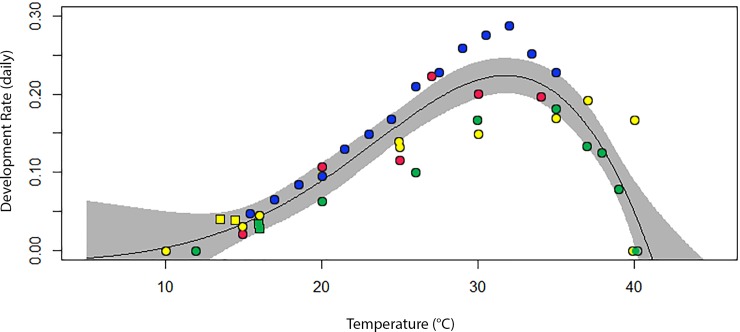
Non-linear development model for larval Aedes aegypti.Comparison of the mean and median time to pupation from published larval development rates, including the current study [14, 26, 30, 31, 32]. To these estimates we fit the temperature dependent model developed by Logan et al. [27]. Colours represent different continents; Africa (blue), Australia (yellow), South East Asia (green) and North America (red); spots represent constant and squares fluctuating temperatures.